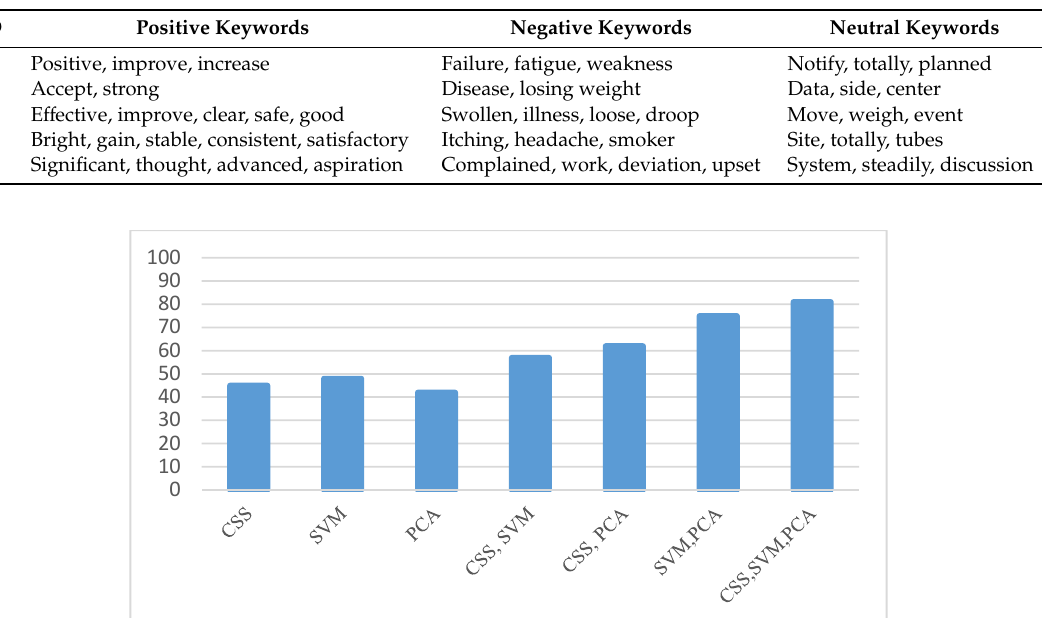
Figure 3. Illustration of the F1 measure when used in three weighing methods with seven different cases.